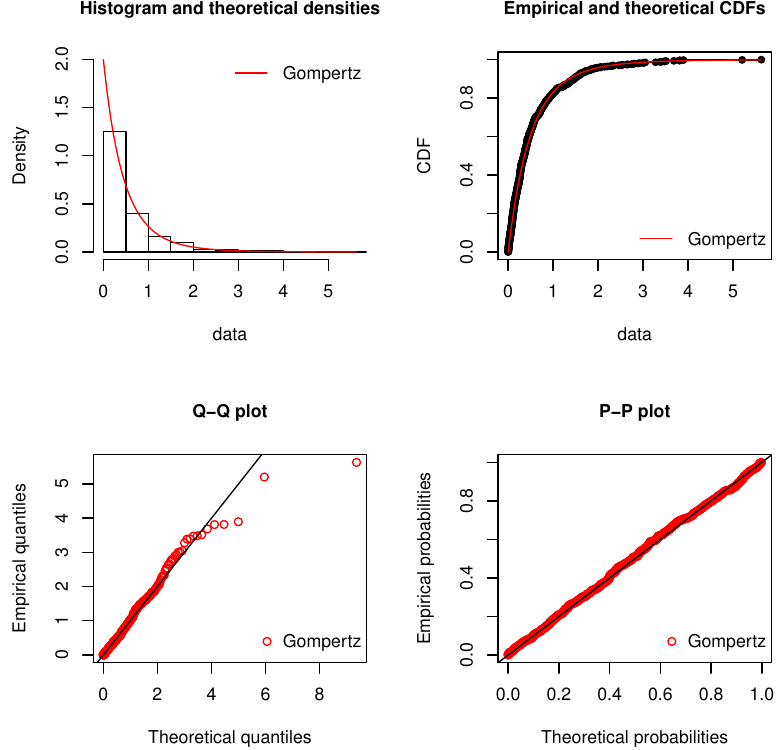
Figure 1 – Graphical fitting of the Gompertz